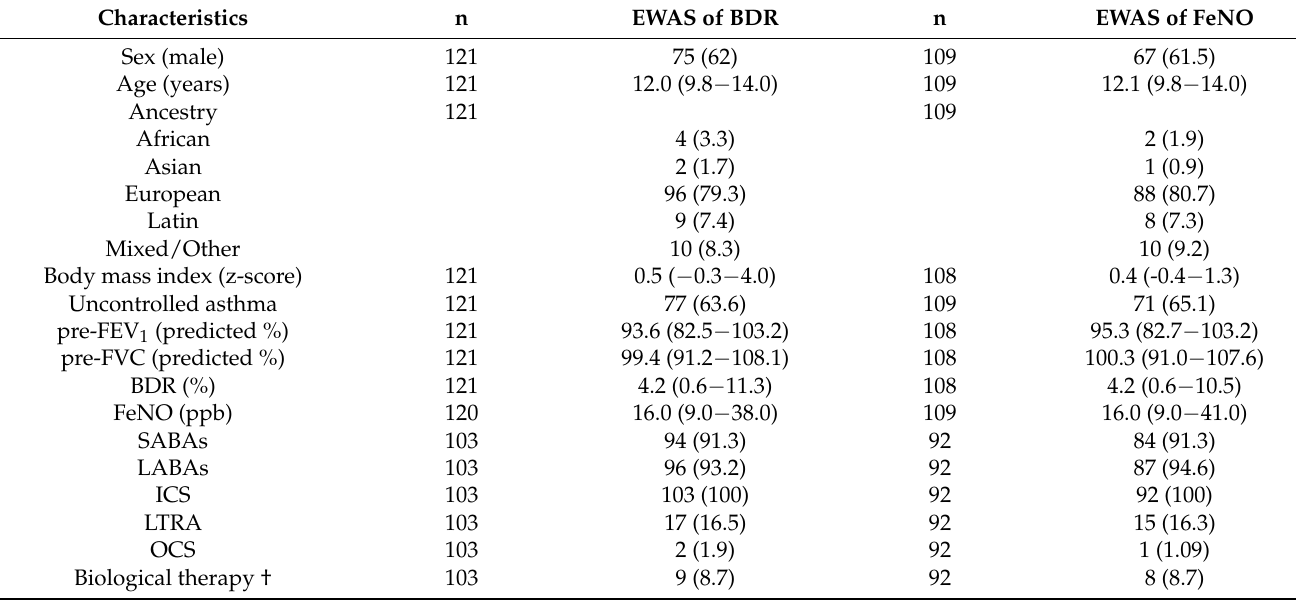
Table 1. Clinical and demographic characteristics of the study